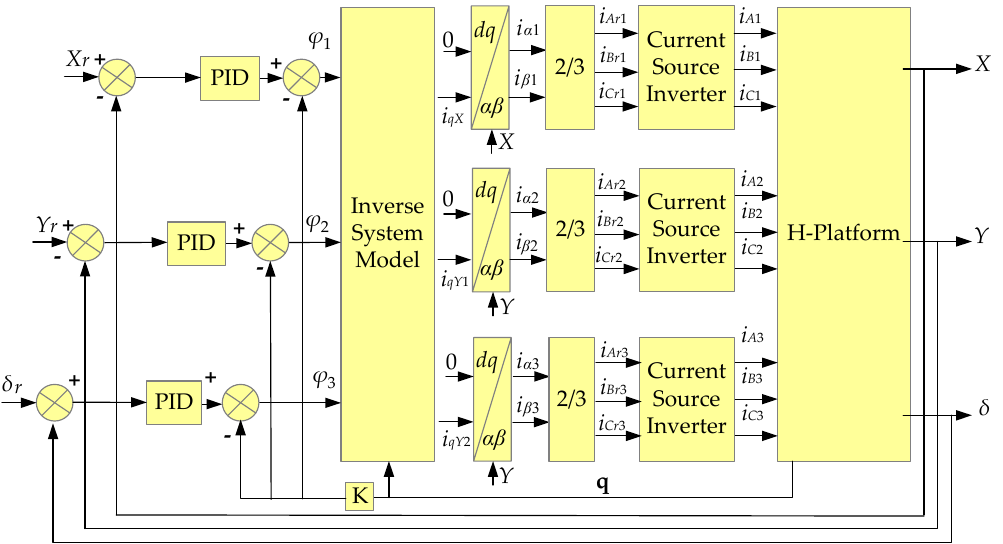
Figure 5. Control system schematic diagram.